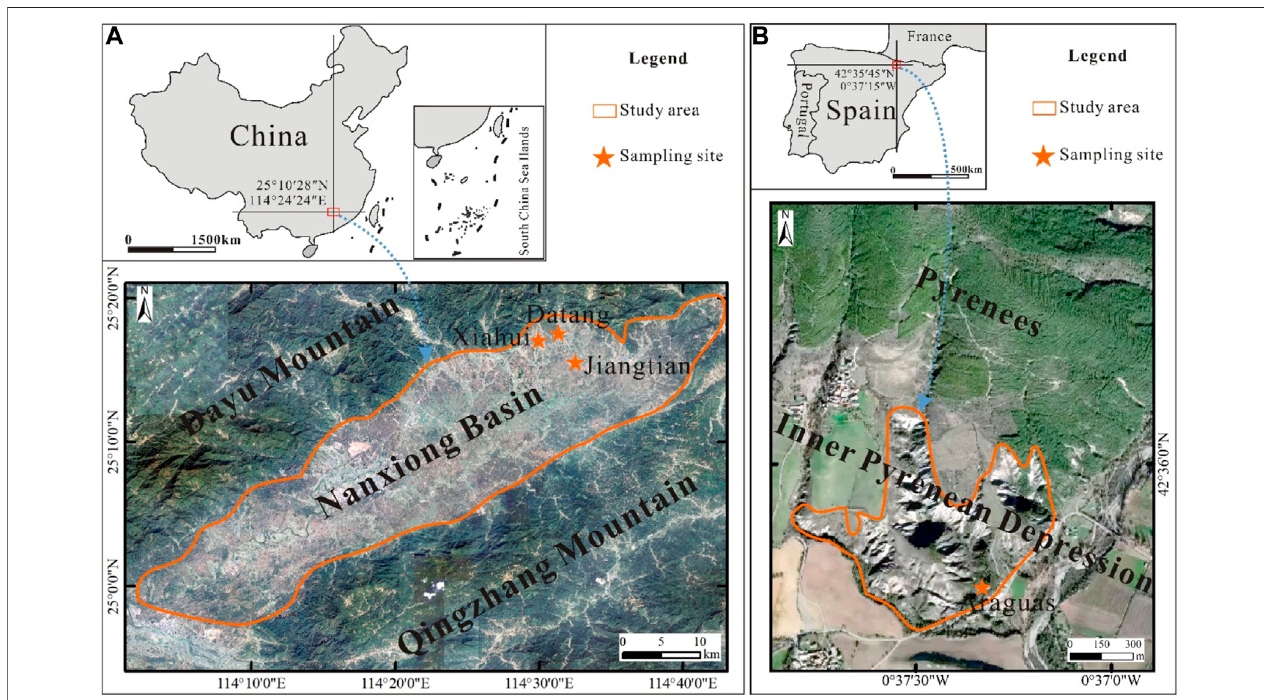
FIGURE 1 | Location of the badland study area and sampling sites in (A) Nanxiong Basin (China) and (B) Inner Pyrenean Depression (Spain) (Source of satellite image: https://earth.google.com/).